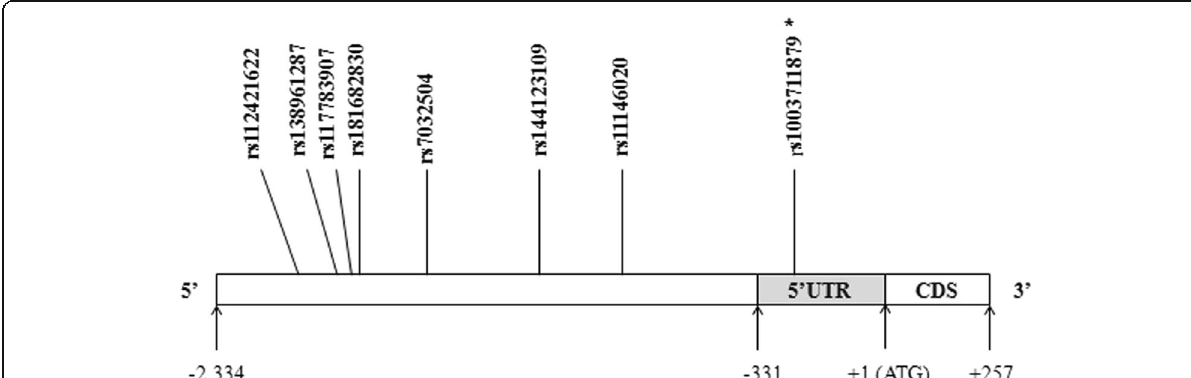
Fig. 1 Schematic diagram of the distribution of seven SNP loci in the GRIN1 gene. The detailed position of the fragment used for Sanger DNA sequencing in the GRIN1 gene 5 ′ promoter region was located between − 2334 bp and + 86 bp. * denotes the SNP not included in the genetic association study because the minimum allele frequency was less than 0.01